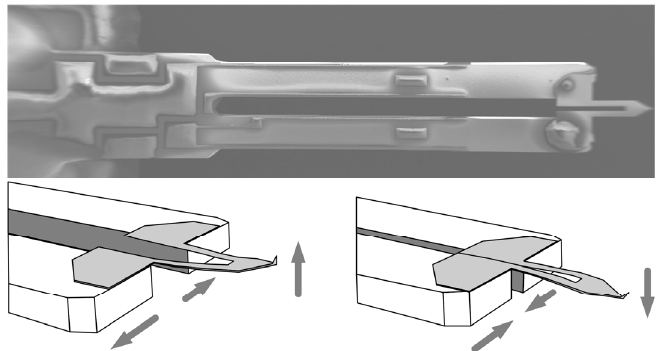
Figure 6. The appearance and motion (arrows in the figures) of the Akiyama probe.